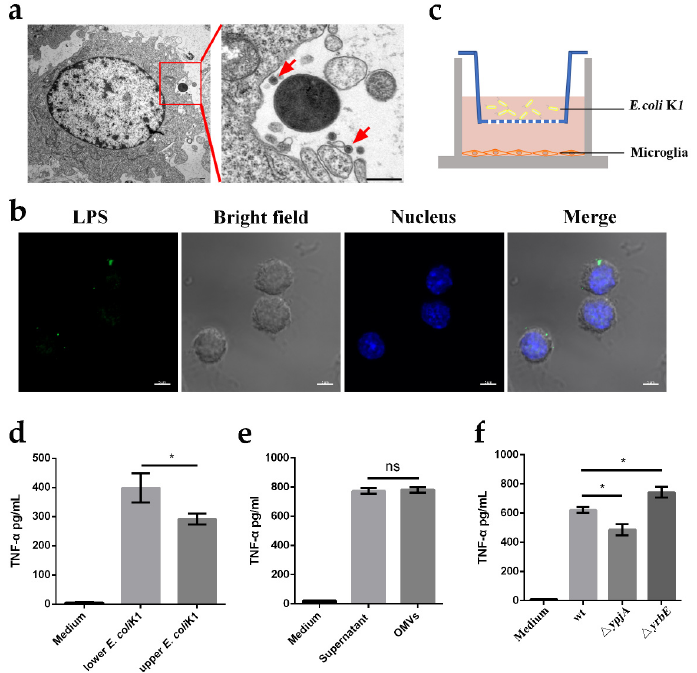
Figure 3. Microglia recognize E.-coli- K1-derived outer membrane vesicles (OMVs) to release TNF- α . ( a , b ) Transmission electron microscopy ( a ) and confocal laser microscopy ( b ) were utilized to observe the secretion of OMVs by E. coli K1 when the bacteria were cultured with primary microglia. Images are representative of three independent experiments. High magnification image of red boxed area is shown on the right panel and red arrows indicate the observed OMV (a). Scale bars, 500 nm ( a ) and 20 μ m ( b ). ( c ) Experiment scheme to determine the inflammatory activation of mi- croglia by bacteria-secreted factors using Transwell plate. ( d ) ELISA analysis of TNF- α protein levels of BV2 microglia cell line incubated with wild-type E. coli K1 in the lower wells or upper wells. ( e ) ELISA analysis of TNF- α protein levels in microglia that were stimulated with bacterial supernatant or purified OMVs. ( f ) ELISA analysis of TNF- α protein levels in microglia that were cultured with wild-type E. coli K1, Δ ypjA , or Δ yrbE . Data are presented as mean ± SD, n = 3 independent experi- ments. p values were determined using Student’s t -test ( d – f ). * p < 0.05; ns, not significant.